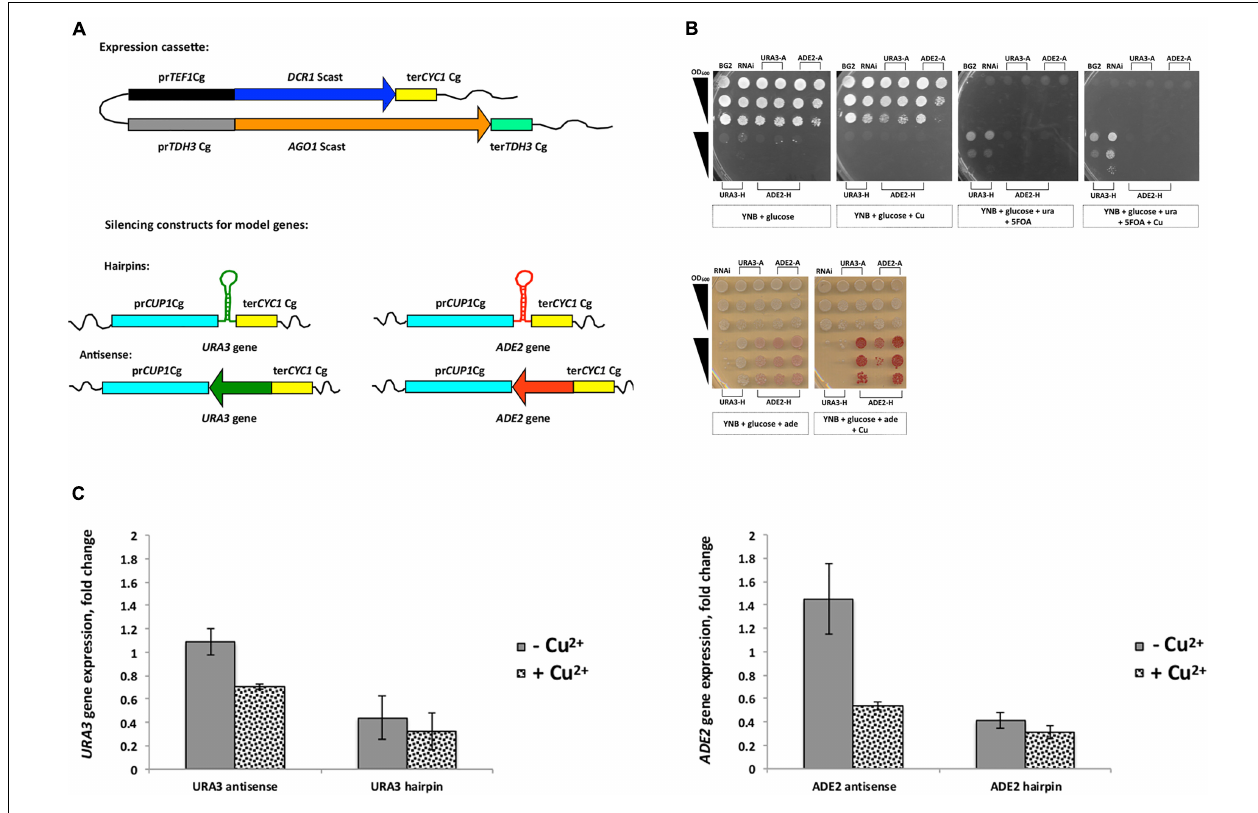
FIGURE 1 | Introduction of RNA interference (RNAi) into C. glabrata. (A) Schematic view of the plasmid carrying the expression cassettes for the DCR1 and AGO1 genes of S. castellii (P1062), which was integrated into the genome; the DCR1 cassette consisted of the promoter TEF1 and the terminator CYC1 of C. glabrata; the AGO1 cassette consisted of the promoter TDH3 and the terminator TDH3 of C. glabrata; the silencing constructs (antisense and hairpins) targeting two model genes of the C. glabrata genome, URA3 and ADE2, were expressed under control of the inducible promoter CUP1 with the terminator CYC1 , both of C. glabrata. (B) Growth phenotypes of C. glabrata transformant carrying RNAi constructs for URA3 and ADE2 genes (hairpin [H] and antisense [A]). Serial dilutions of cells (OD 600 1; 0.1; 0.01) were plated on different media with and without copper (YNB; YNB with adenine; YNB with 5-FOA and uracil); Strains are as follows: 1 – BG2; 2 – Y1662 carrying P1028 (RNAi negative control); 3 – URA3 antisense-8; 4 – URA3 antisense-12; 5 – ADE2 antisense-5; 6 – ADE2 antisense-10; 7 – URA3 hairpin-4; 8 – URA3 hairpin-7; 9 – ADE2 hairpin-3; 10 – ADE2 hairpin-4; 11 – ADE2 hairpin-10. (C) Expression analysis of ADE2 and URA3 genes in RNAi